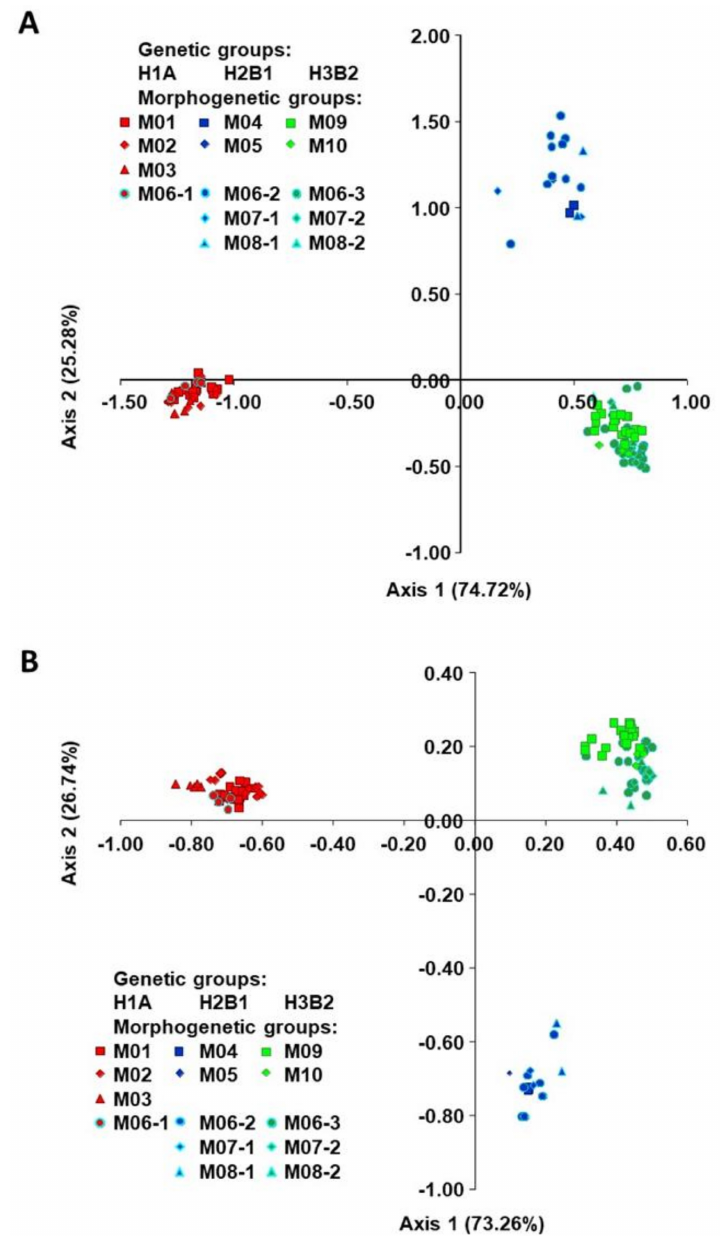
Figure 2. Factorial correspondence analysis (FCA) of true-type common bean accessions based on ( A ) SSRs and ( B ) SNPs. Designations of the groups are given in Table 1. The signs with light blue border indicate the morphotypes (landraces) that had been found in more than one genetic group and reclassified as different morphogenetic groups (M06 to M06-1, M06-2 and M06-3